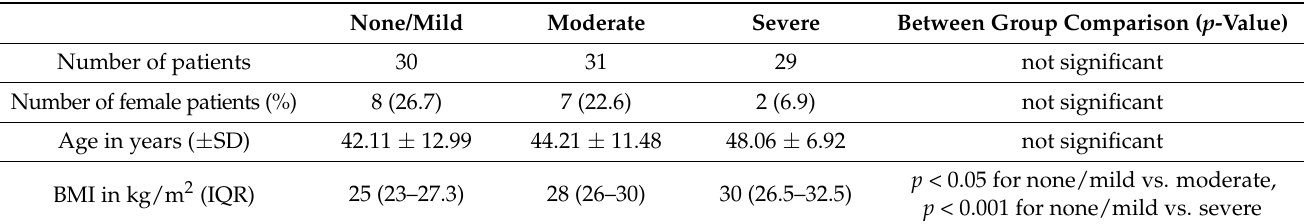
Table 1. Baseline characteristics of the study